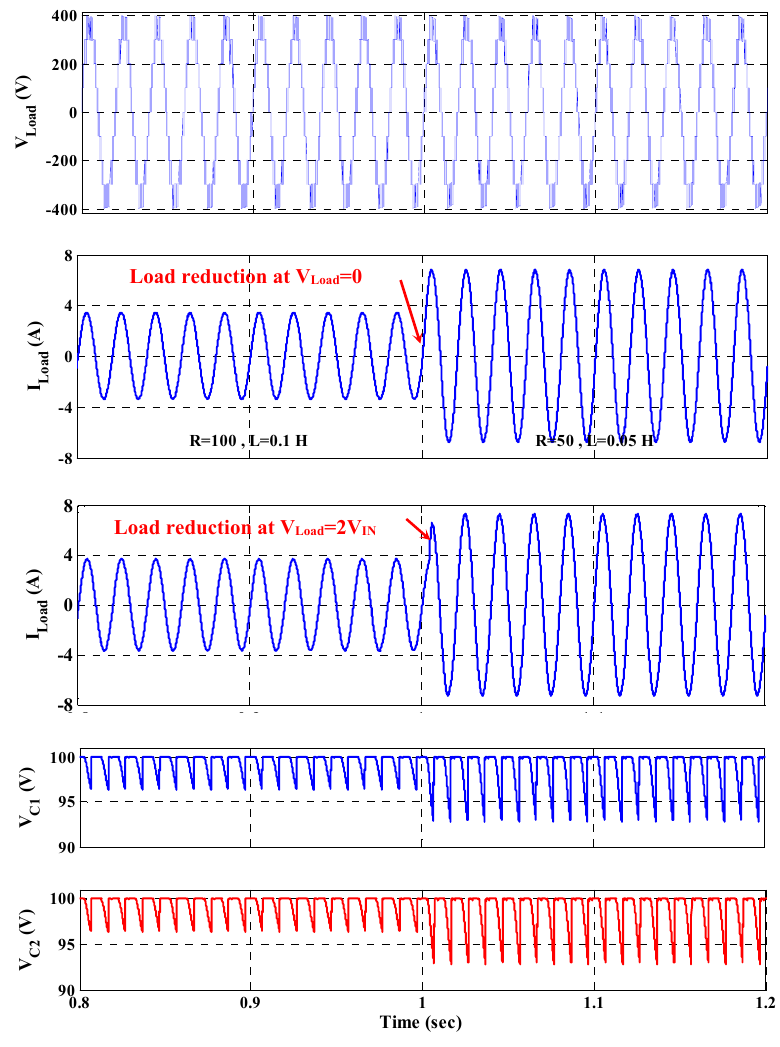
Figure 8. Operation of the presented model under sudden load reduction.